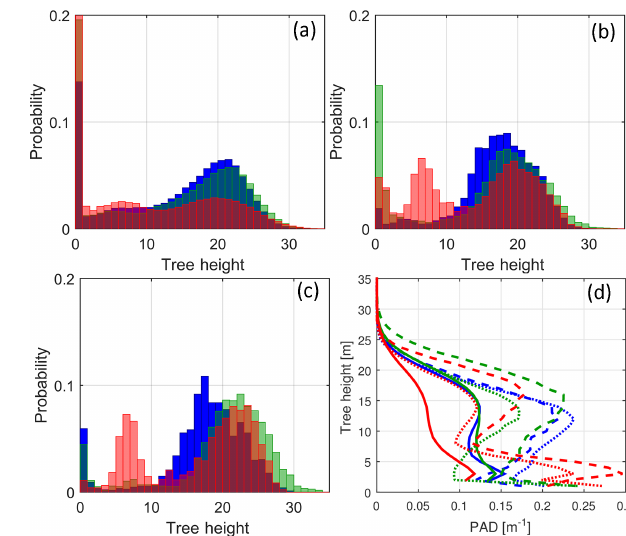
Figure 2. (a–c) Distribution of tree heights in the three sectors within a radius of (a) 10km, (b) 2km, and (c) 1km. The colours indicate sectors 100 ◦ (blue), 240 ◦ (green), and 290 ◦ (red). (d) Av- erage PAD profiles from within 10km are shown as full lines, 2km as dotted lines, and 1km as dashed lines. Colouring is as in the his-